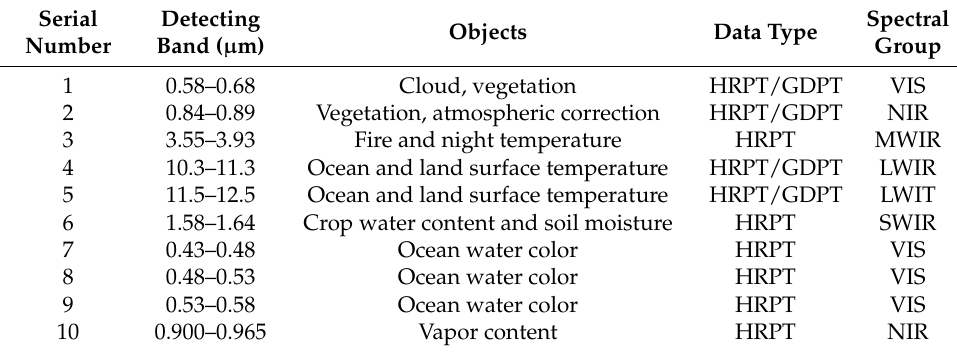
Table 1. Detecting bands of 10-band scanning radiometer, modified from